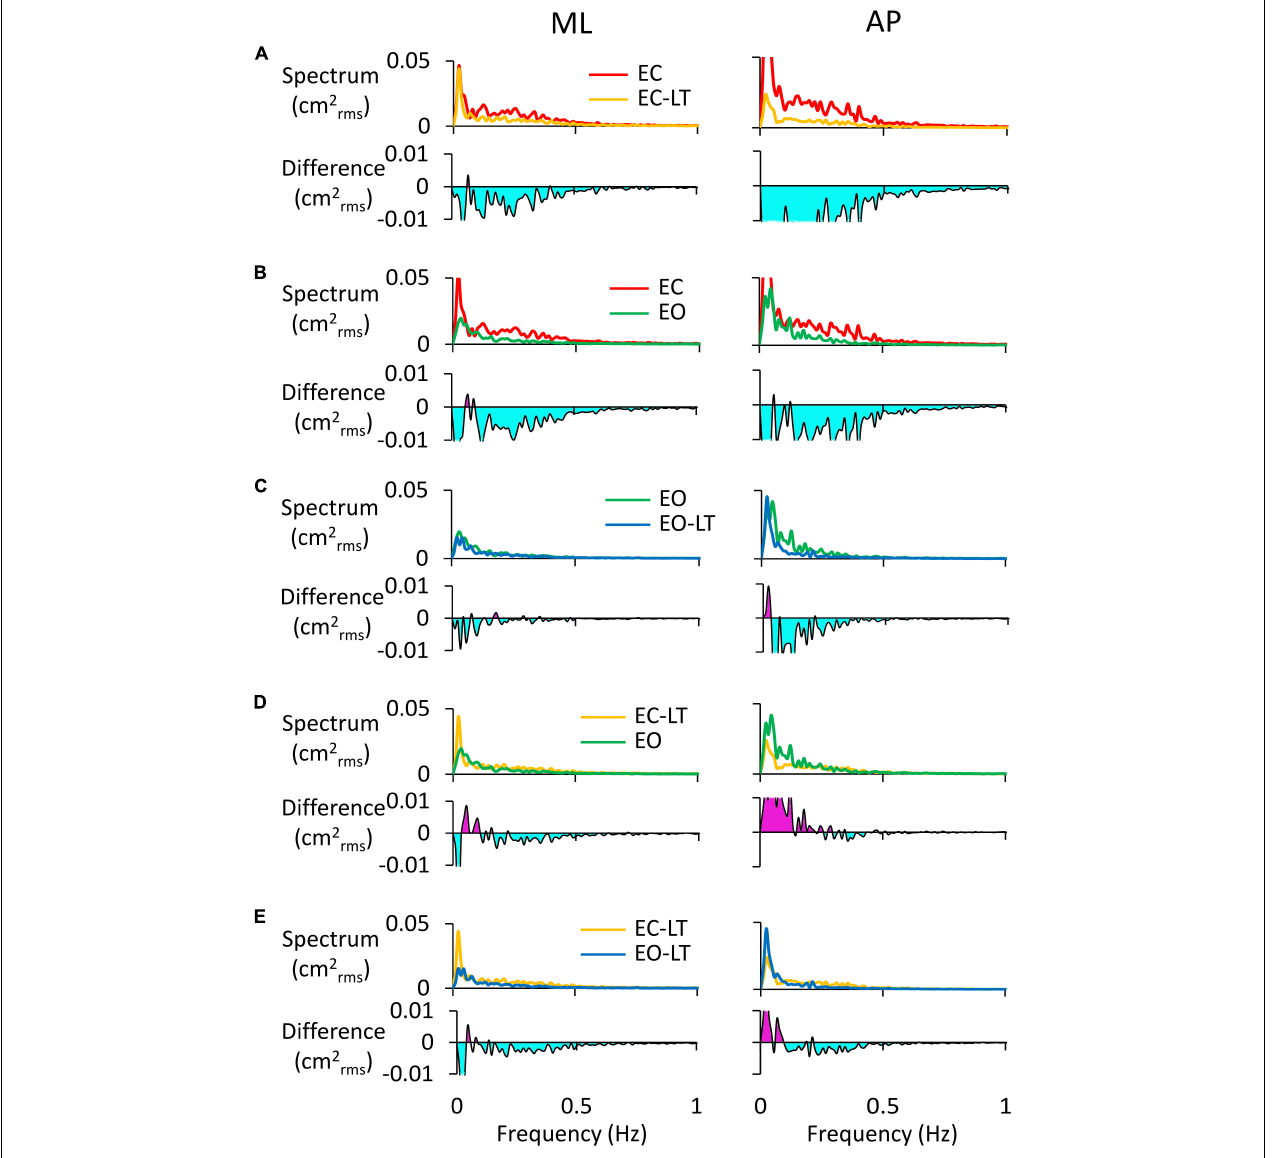
FIGURE 7 | Comparisons of adapted trials between sensory conditions (coloured). In the upper traces of each panel, the mean power spectra of ML (left column) and AP directions (right column) of the last trial are reported and compared. In the lower traces, the difference between spectra is shown: (A) , EC-LT minus EC; (B) , EO minus EC; (C) , EO-LT minus EO; (D) , EO minus EC-LT; (E) , EO-LT minus EC-LT. Light blue areas highlight negative differences between the pairs of sensory conditions. The pink area in (D,E) indicates that the spectrum of the most stabilised condition (e.g., EO in D and EO-LT in E ) is greater than the contrast condition (EC-LT in D,E